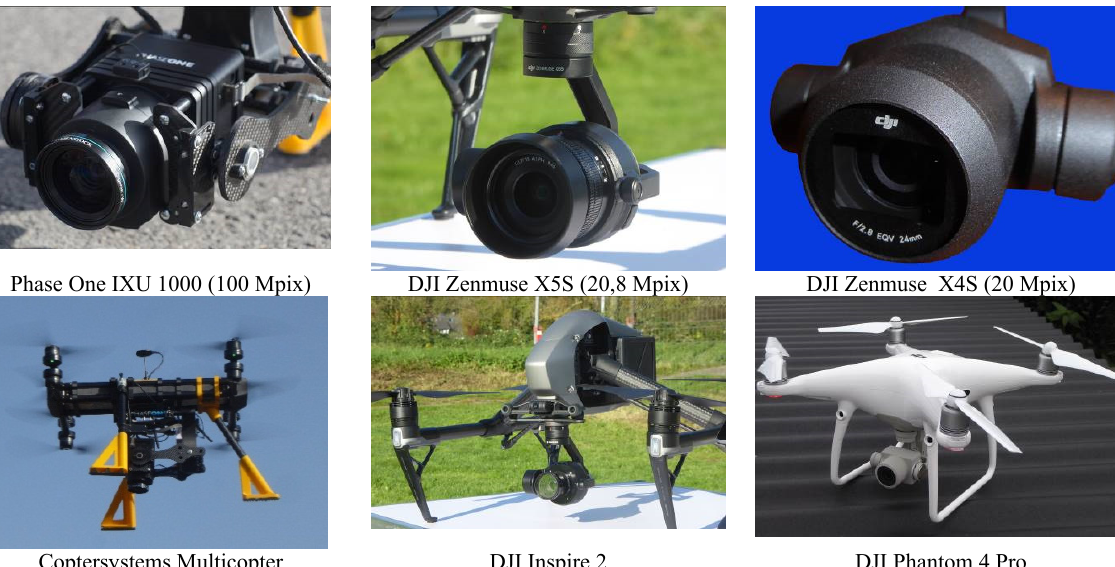
Figure 1. Cameras and carrier platforms under